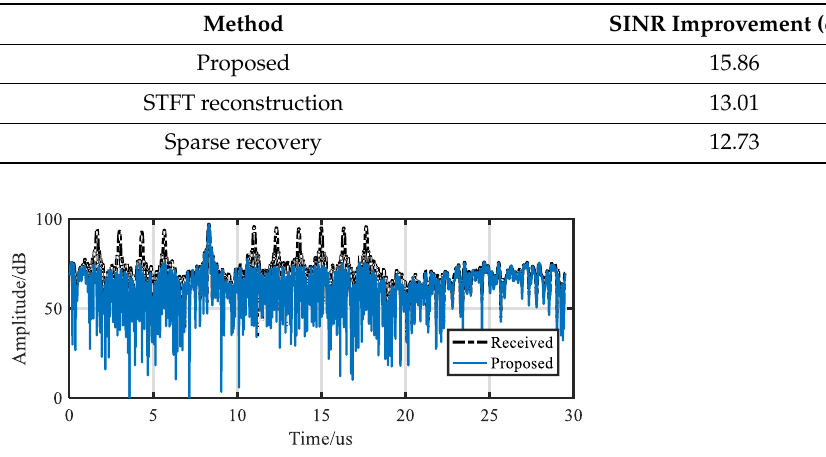
Table 3. Average SINR improvement of various methods.